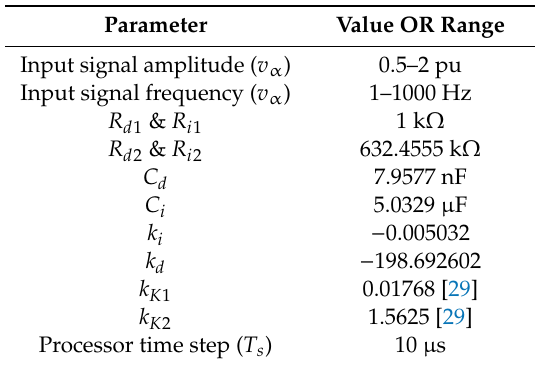
Figure 20. Experimental setup built for the system validation.